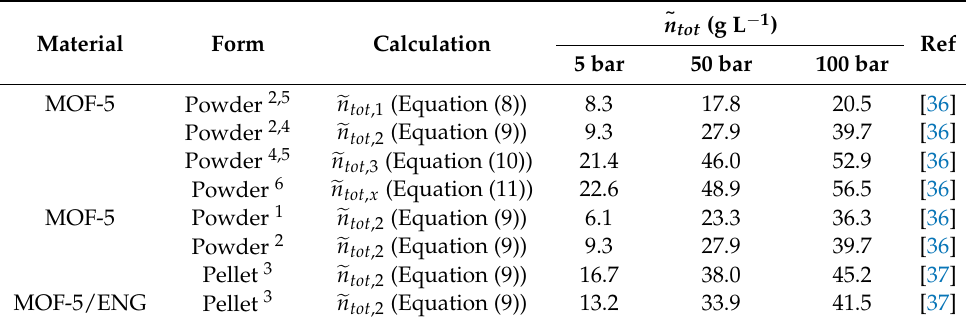
Table 1. Representative measurements and methods of calculation of volumetric H 2 storage calcula- tions on MOF-5 (as shown in Figure